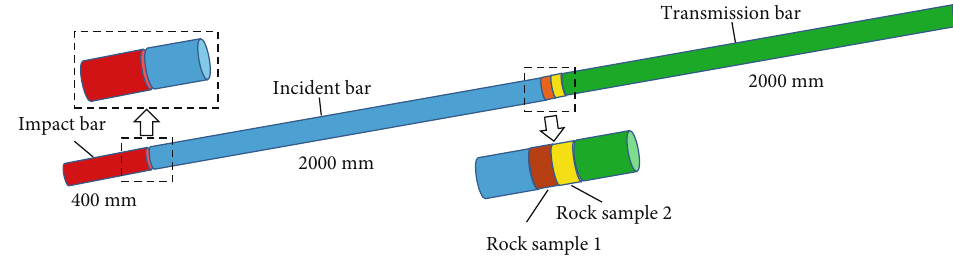
Figure 2: SHPB numerical simulation